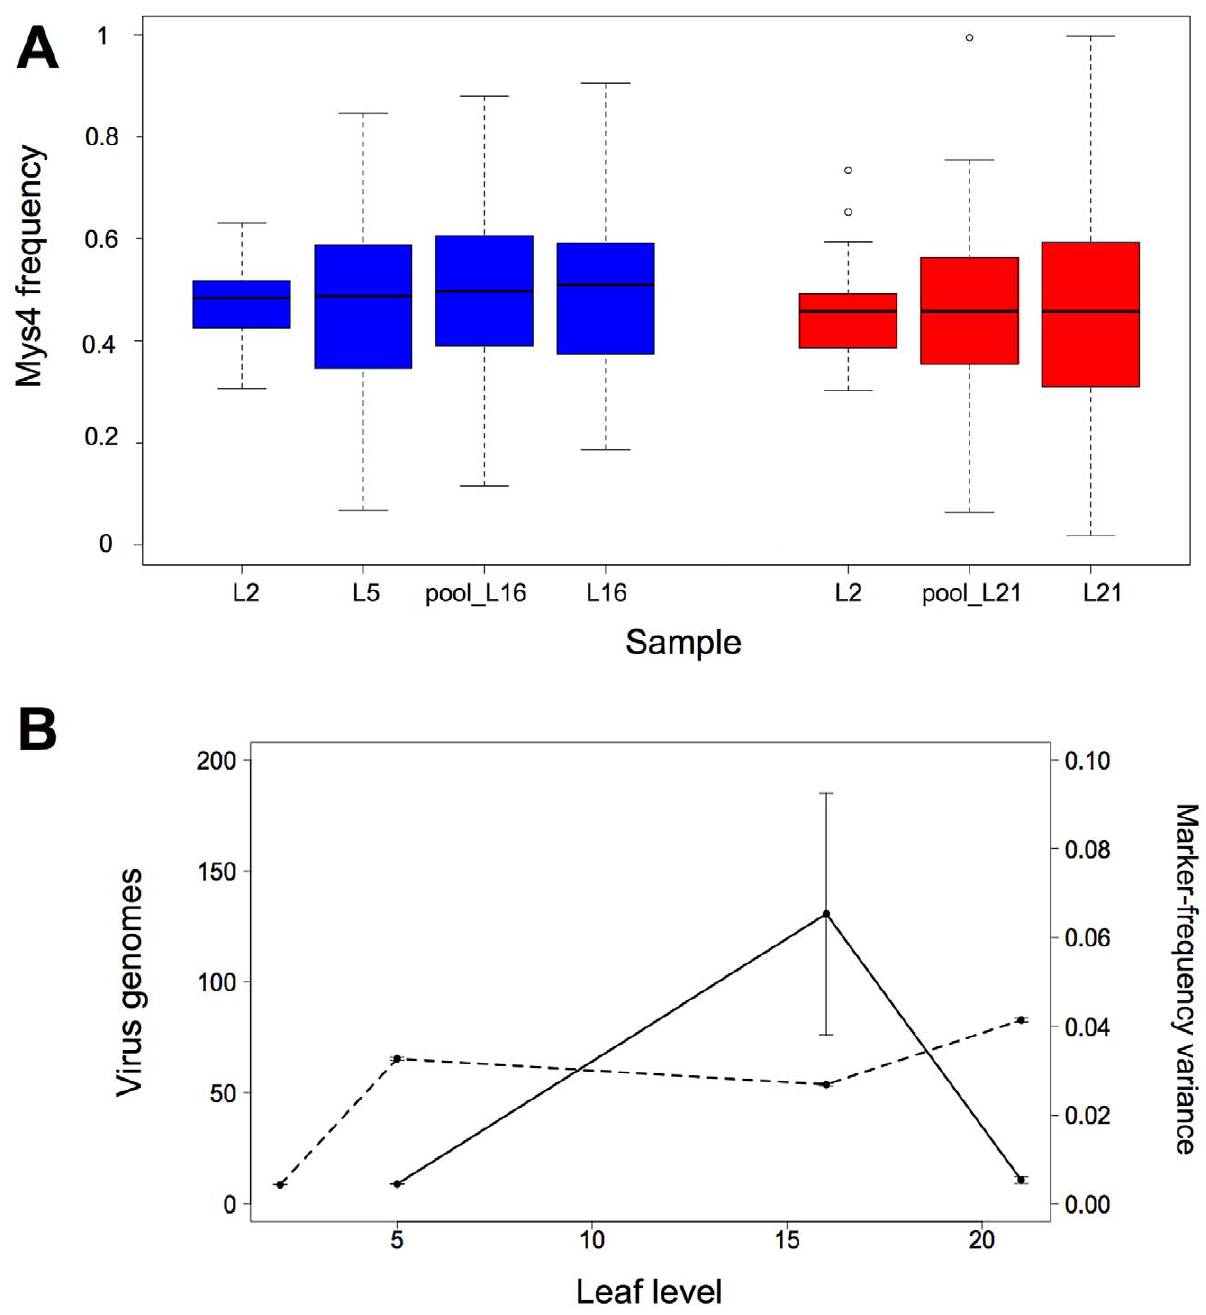
Figure 2. Bottleneck sizes at CaMV entry into different leaf levels. (A) Boxplot of the Mys4 frequency distributions in samples harvested successively in two sets of 50 replicate plants. In the first set of plants (blue), harvested samples were leaf level 2 (L2), leaf level 5 (L5), pooled leaves below leaf level 16 (pool_L16), and leaf level 16 (L16). In the second set of plants (red), harvested samples were leaf level 2 (L2), pooled leaves below leaf level 21 (pool_L21), and leaf level 21 (L21). The average frequency of Mys4 did not vary during CaMV progression into host plants, demonstrating the equi-competitiveness of Mys4 and Mys7 (linear mixed-effects model with leaf level as a fixed effect and plant as a random effect: p-values=0.450/ 0.818, and the slope of the two linear regressions of Mys4 frequency over time is not significantly different from 0: p-values=0.124/0.616). (B) The full line shows changes in the average number of CaMV genomes founding the population in successive leaf levels. The number of viral genome founders (CI 95% ) in leaf levels 5, 16 and 21 was: 8.8 (6.4–14.1), 124.7 (19.1–908.9) and 10.8 (7.1–23.9), respectively. The dashed line represents changes in the variance of Mys4 frequency among repeated plants at successive leaf levels (scale on the right). Confidence limits for variance values were obtained using a resampling technique (1000 bootstraps sampling 50 frequency values with replacement). Error bars represent standard errors. doi:10.1371/journal.ppat.1003009.g002 (number of copies estimated from pools of five aphids, divided by 5 aphids (and other hemipteran insects) readily assimilate free amino to provide a per aphid number as in Figure 1, and by 25 to provide acids, but poorly degrade proteins [32—34][35]. However, in a per nanoliter number). The current literature suggests that additional experiments where aphids were fed with artificial